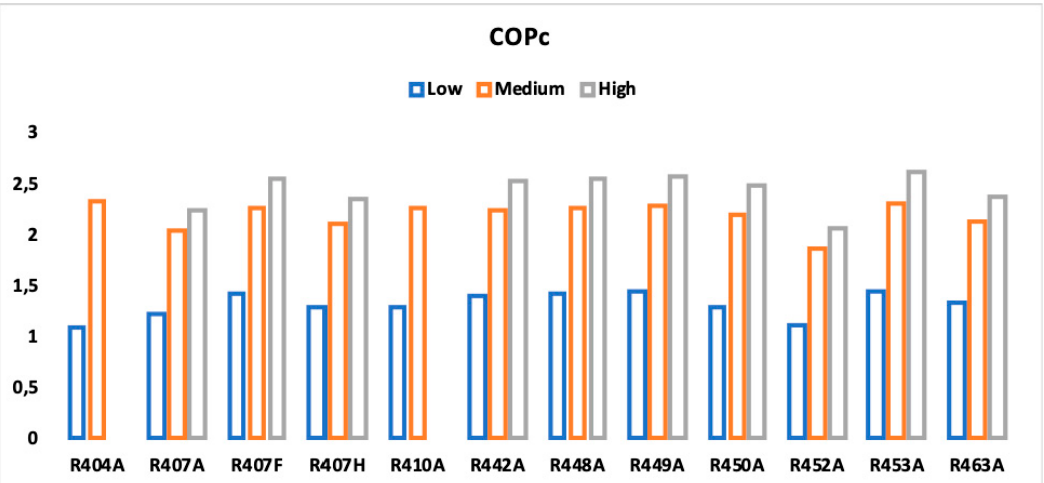
ffi cient of performance (COPc) for all Figure 17. C ooling coefficient of performance (COPc) for all refrigerants. Figure 17. Cooling coe